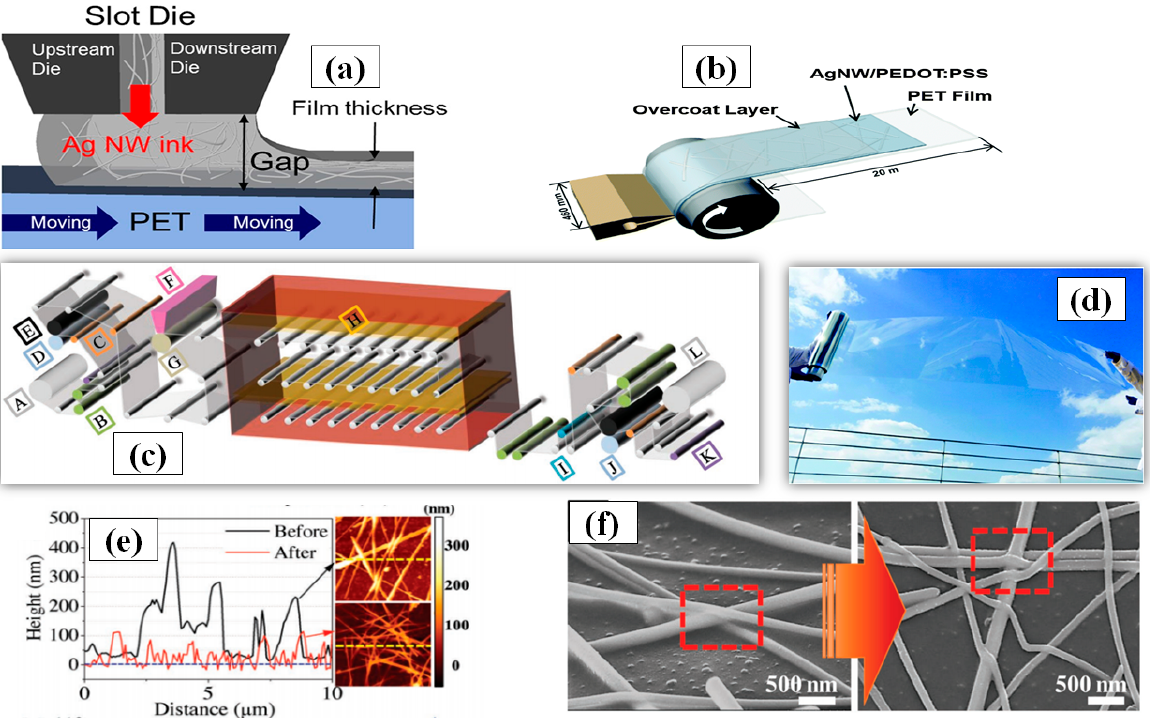
Figure 14. ( a ) schematic structure of a slot die head used for Ag NW coating with the influencing parameters (adapted from [188] with permission from John and Wiley sons, 2018) ( b ) A Schematic diagram of slot-die roll-coating process and structure of the AgNW/PEDOT:PSS conducting film (adapted from [187] with permission from Royal Society of Chemistry, 2015) ( c ) Roll to Roll slot-die coating of AgNWs: ( a ) schematic of R2R slot-die coating with calendaring process machine (A: unwinder, B: edge position controller, C: load cell, D: infeeder, E: nip roll, F: slot-die, G: backup roll, H: far-infrared dryer, I: accumulator, J: outfeeder, K: dancer, L: rewinder (adapted from [189] with permission from Springer nature, 2016) ( d ) Photographic image of the AgNW/PEDOT:PSS conducting roll film fabricated in this study (adapted from [187] with permission from Royal Society of Chemistry, 2015) ( e ) AFM data before and after calendaring ( f ) SEM image of AgNWs before and after calendering process. (adapted from [189] with permission from Springer nature, 2016)